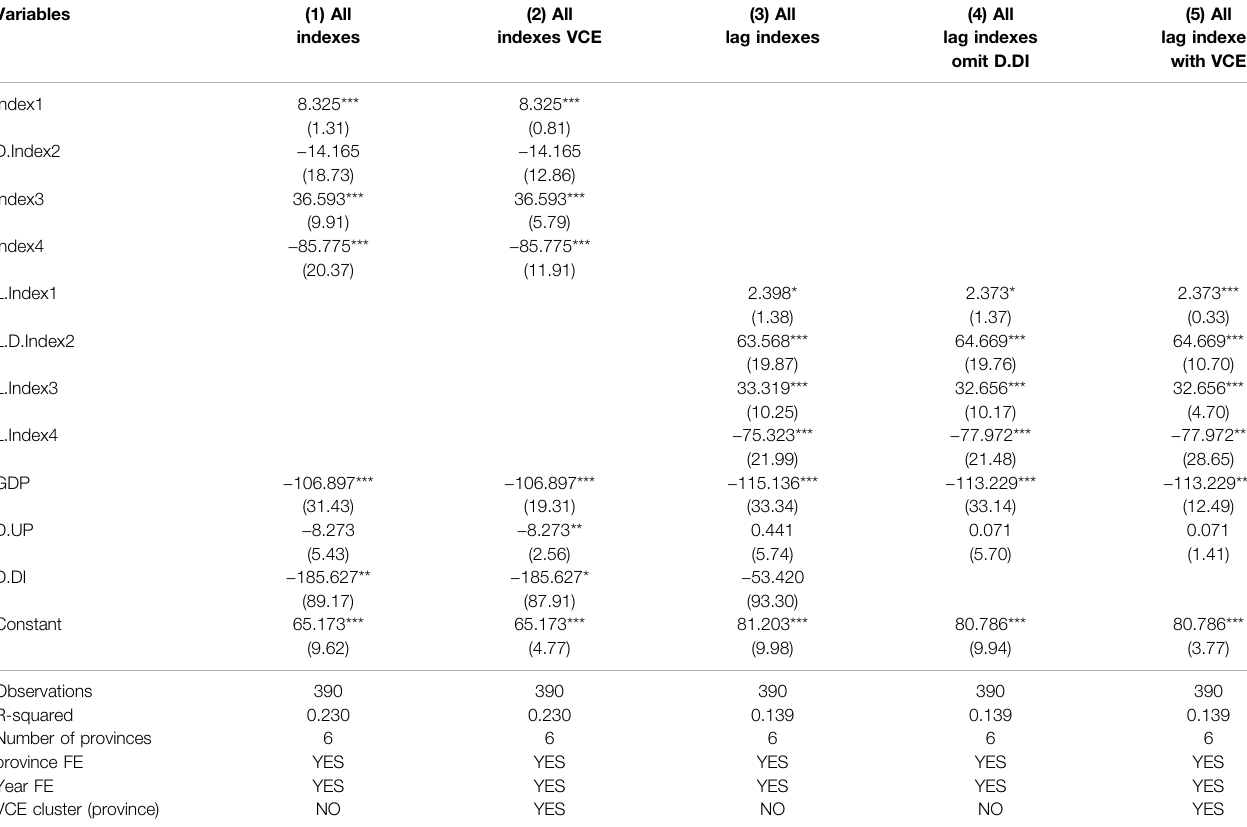
TABLE 7 | Model estimation results using Baidu search index regarding the central district of China.